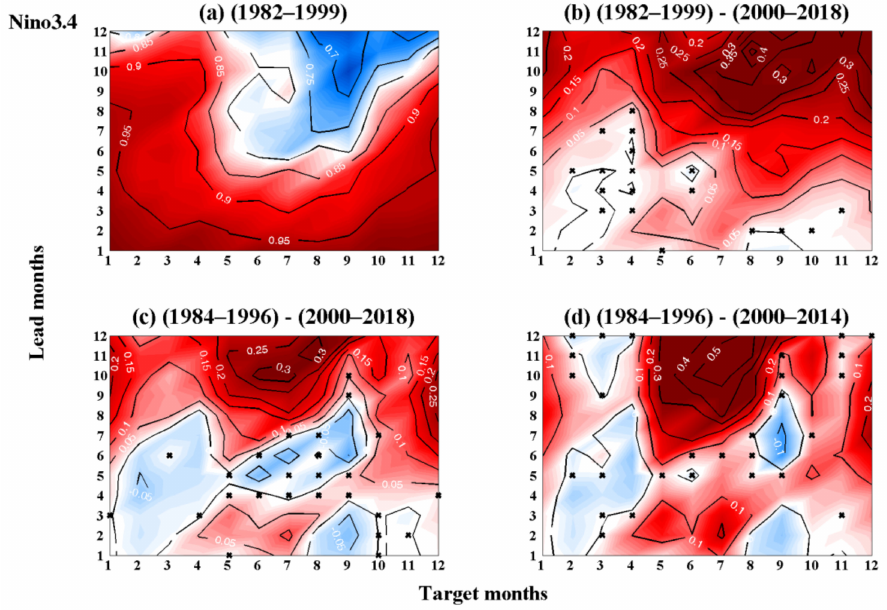
Figure 2. ( a ) Distributions of the temporal correlation of the MME forecasts and observations during 1982–1999 as a function of target months and lead months for the Niño3.4 index. ( b – d ) Skill differences for the periods shown in each subtitle. Note: the black crosses indicate that the skill differences are not statistically significant at the 5% level based on a Student’s t -test.